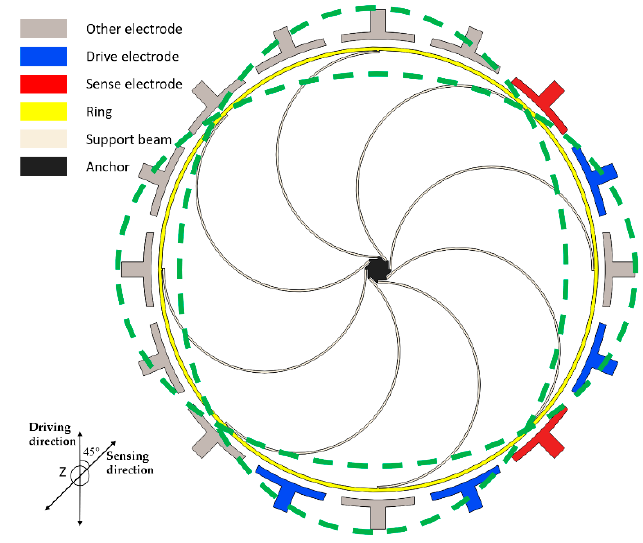
Figure 1. Schematic view of a typical vibrating ring gyroscope.